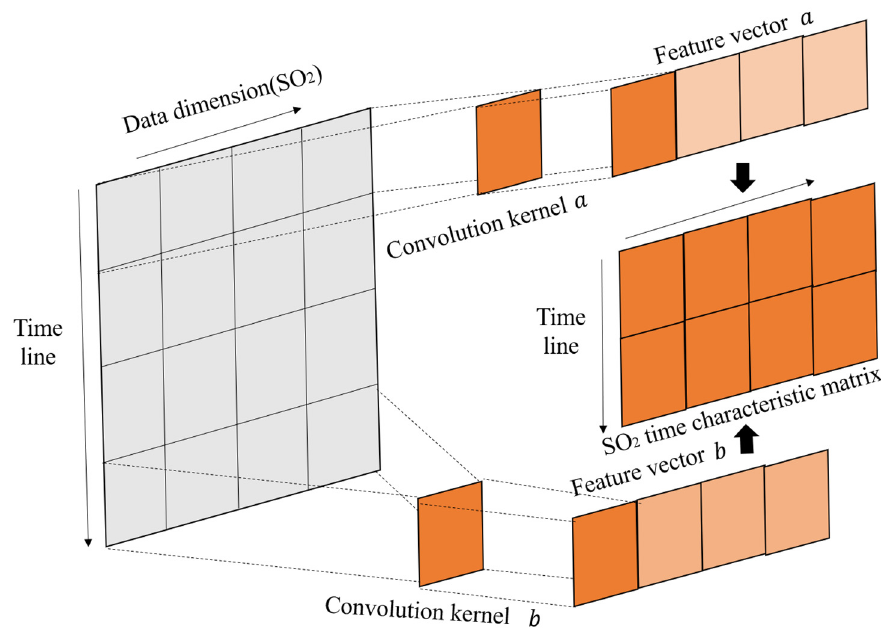
Figure 3. One-dimensional convolution feature extraction process